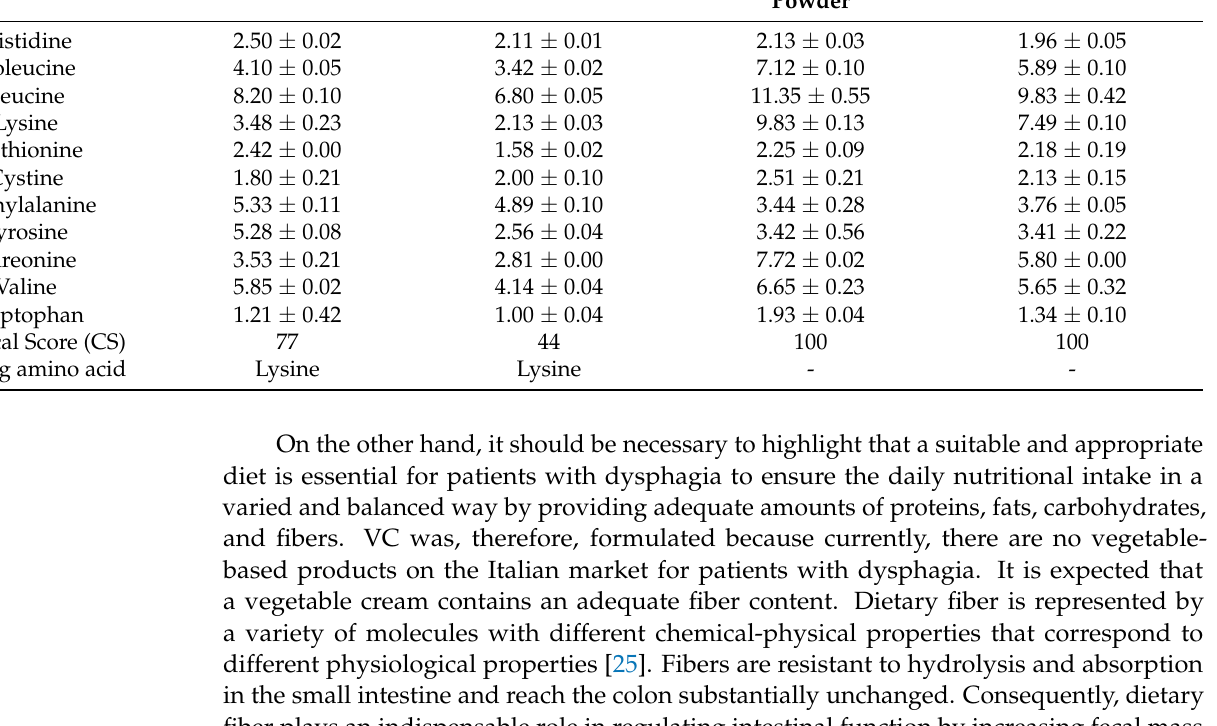
Table 4. Essential Amino Acid (g/100 g protein), Chemical Score (CS) and limiting amino-acid of rice flour, emmer flour, whey proteins powder, and Protein Meal (PM). Essential Amino Acid Rice Flour Emmer Flour